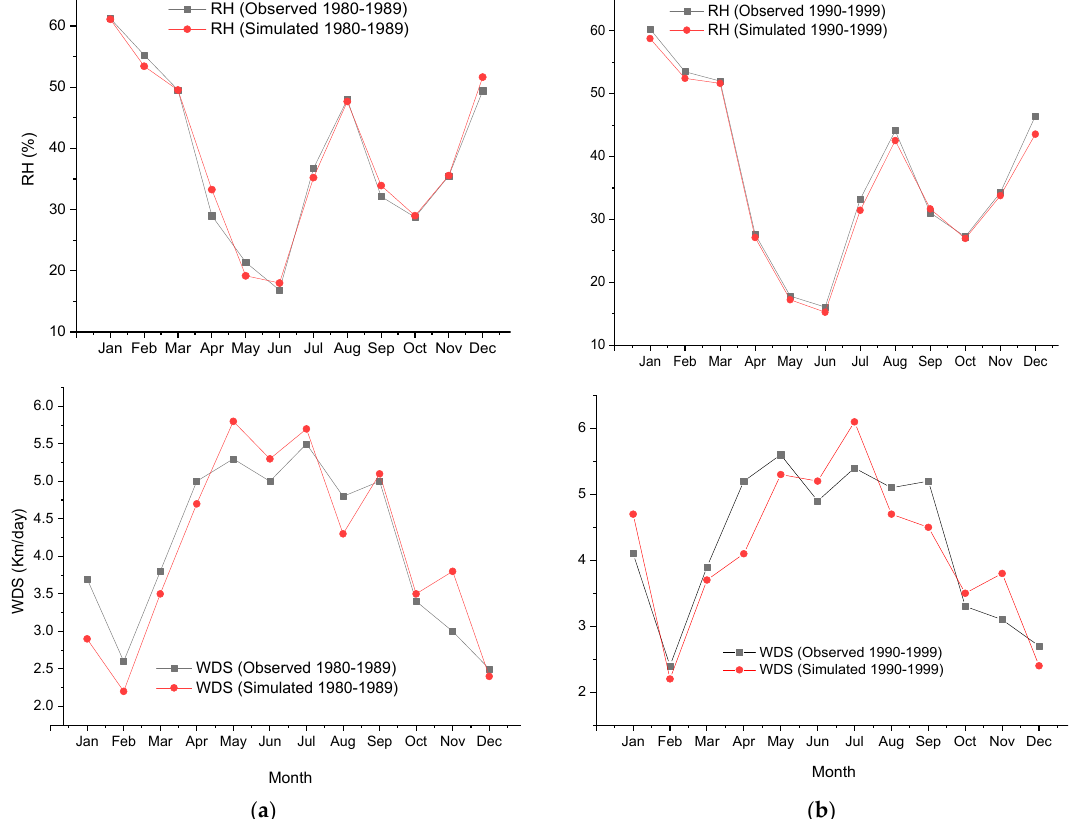
Figure 4. Comparison of observed and modeled (NCEP) mean monthly Tmax (maximum temperature, Tmin (minimum temperature), Precp (precipitation), WDS (Wind speed), and R.H (relative humidity) during ( a ) calibration period (1980–1989) and ( b ) validation period (1990–1999).